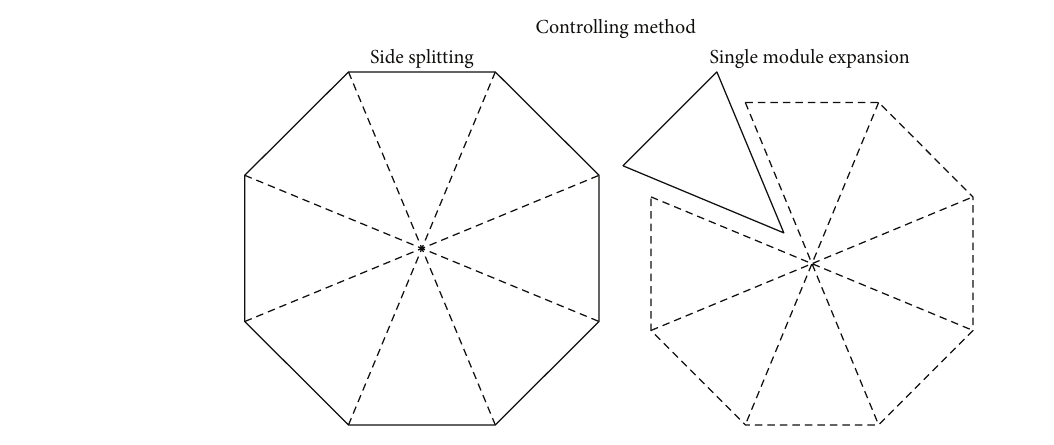
Figure 12: Types of controlling method.